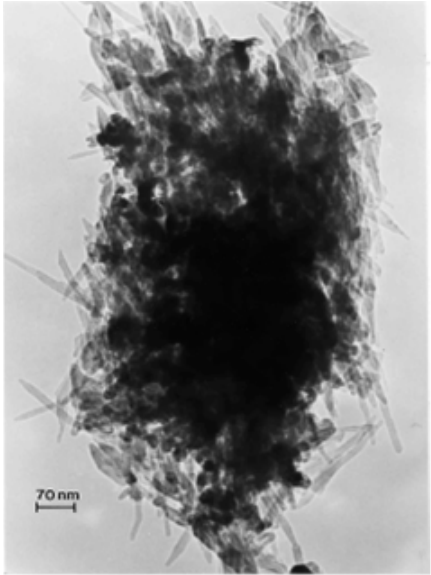
Figure 6: Typical PM example (d 0.6µm) of carbon nanotube / nanocrystal polyhedra aggregate collected from the roof-top exhaust of a natural gas water